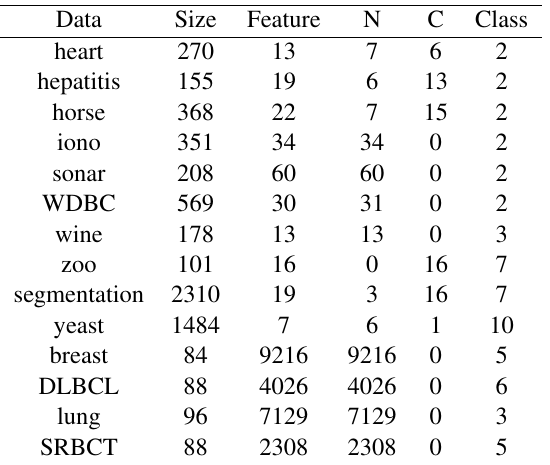
Table 1: Summary of data